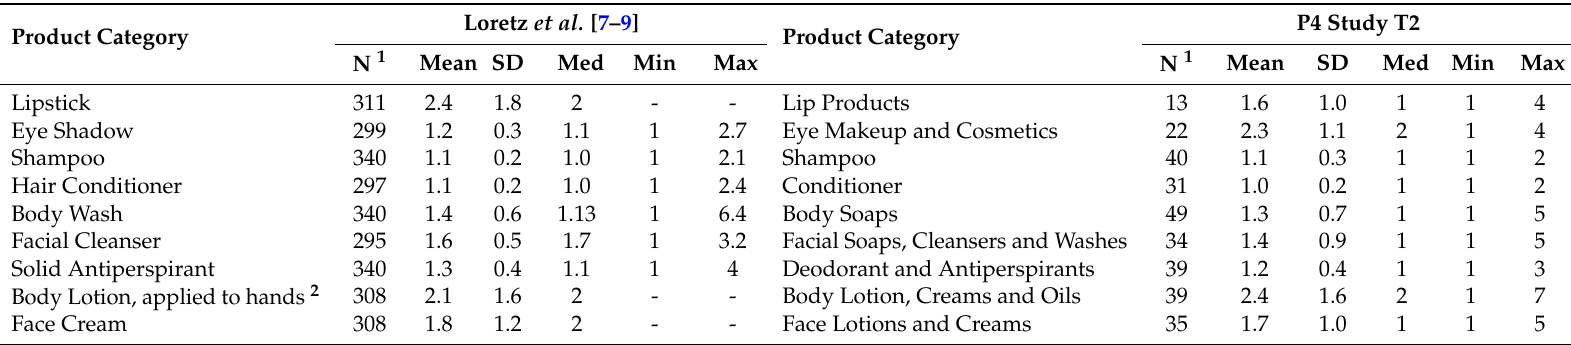
Table 5. Comparison of the use frequency (per day) of PCPs between an adult female US population Loretz et al. [7–9] and the P4 Study during the second trimester of pregnancy. Only category “users” were included for both